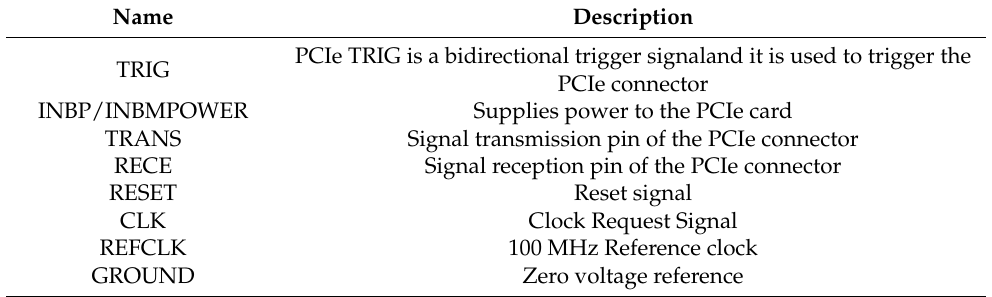
Figure 8. Connection circuit diagram of FPGA and PCIe. Table 2. Pin functions of the PCIe connector.